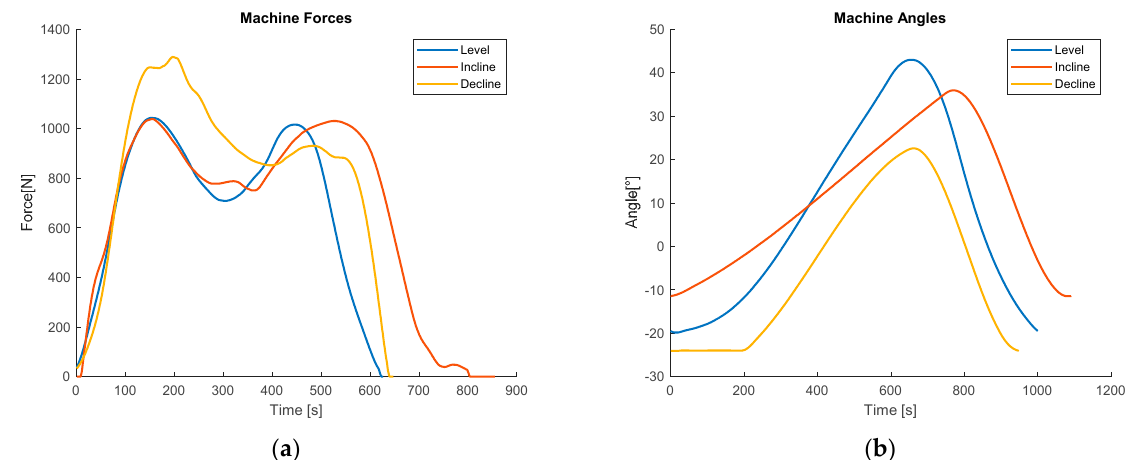
Figure 4. Machine inputs for vertical force and tilt-table rotation: ( a ) level-ground, incline, and decline vertical force input; ( b ) level-ground, incline, and decline tilt table rotation input.